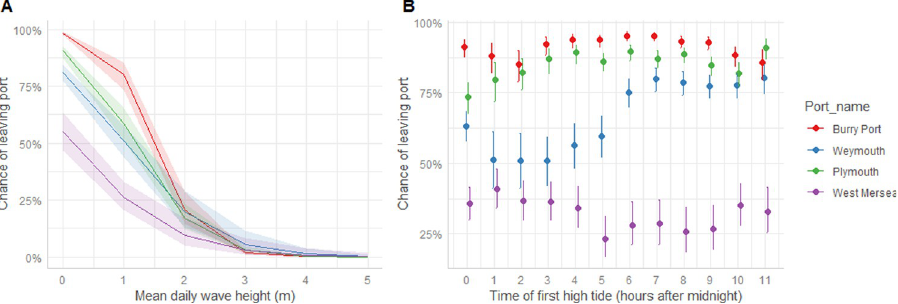
Fig 2. Predictors of whether a vessel will leave port from the binary logistic regression. A) mean significant wave height, B) time of first high tide. Bars and bands indicate confidence intervals. For both figures, colours are used to distinguish between ports where Red = Burry port, Blue = Plymouth, Green = West Mersea and Purple = Weymouth.